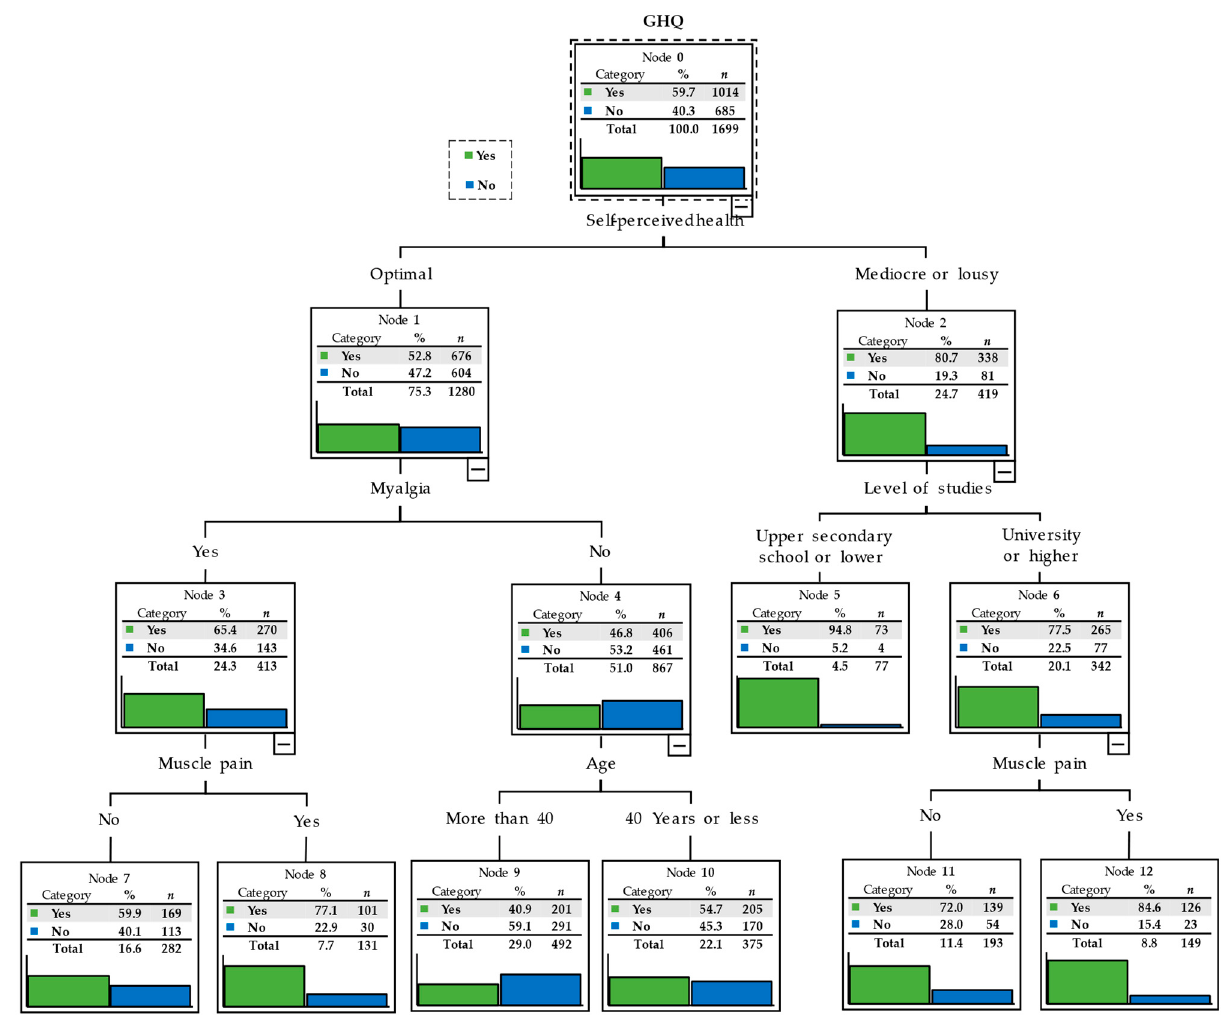
Figure 1. Segmentation tree displaying the level of psychological distress.